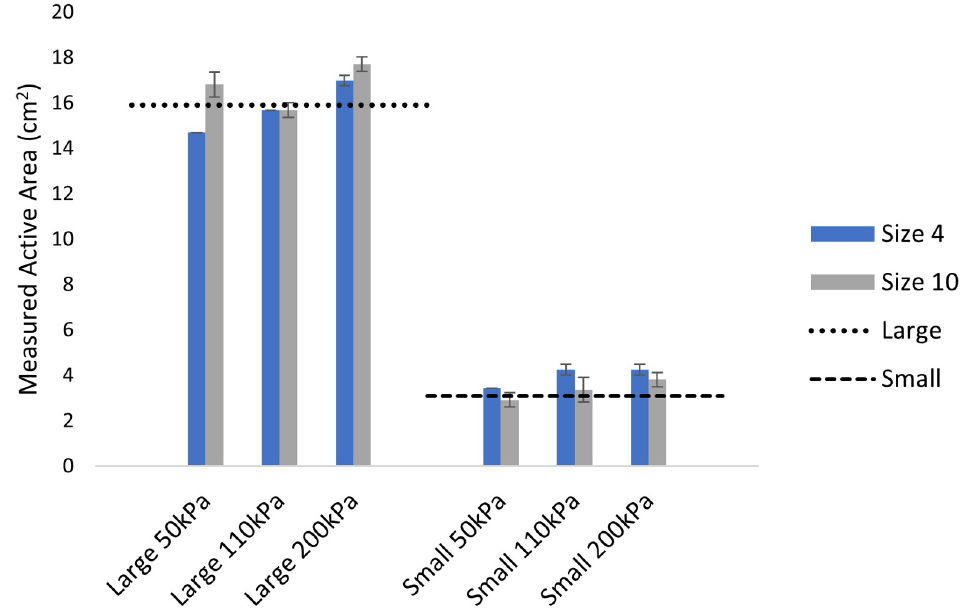
Fig 2. Contact area for each insole and cylinder size for day two across the 2s trial. Error bars denote standard deviation across three trials.